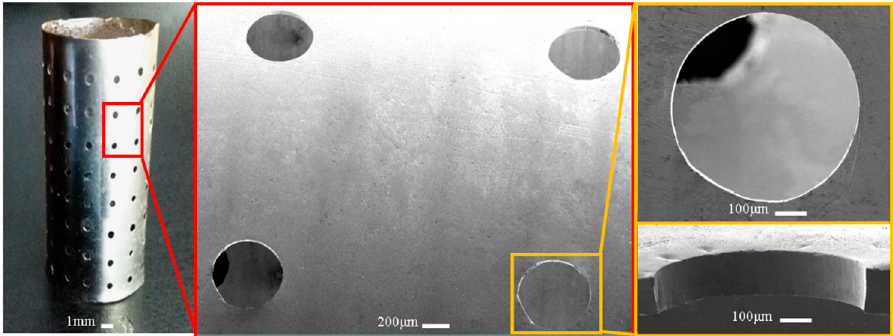
Figure 15. Electroformed hollow seamless cylinder with straight-walled perforations.